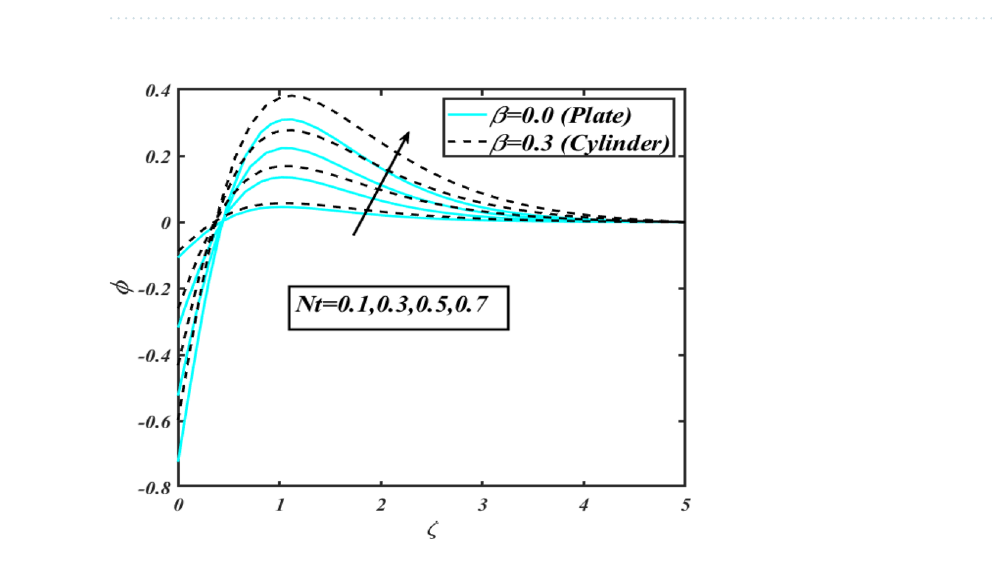
Figure 18. Profile of φ for Nt .